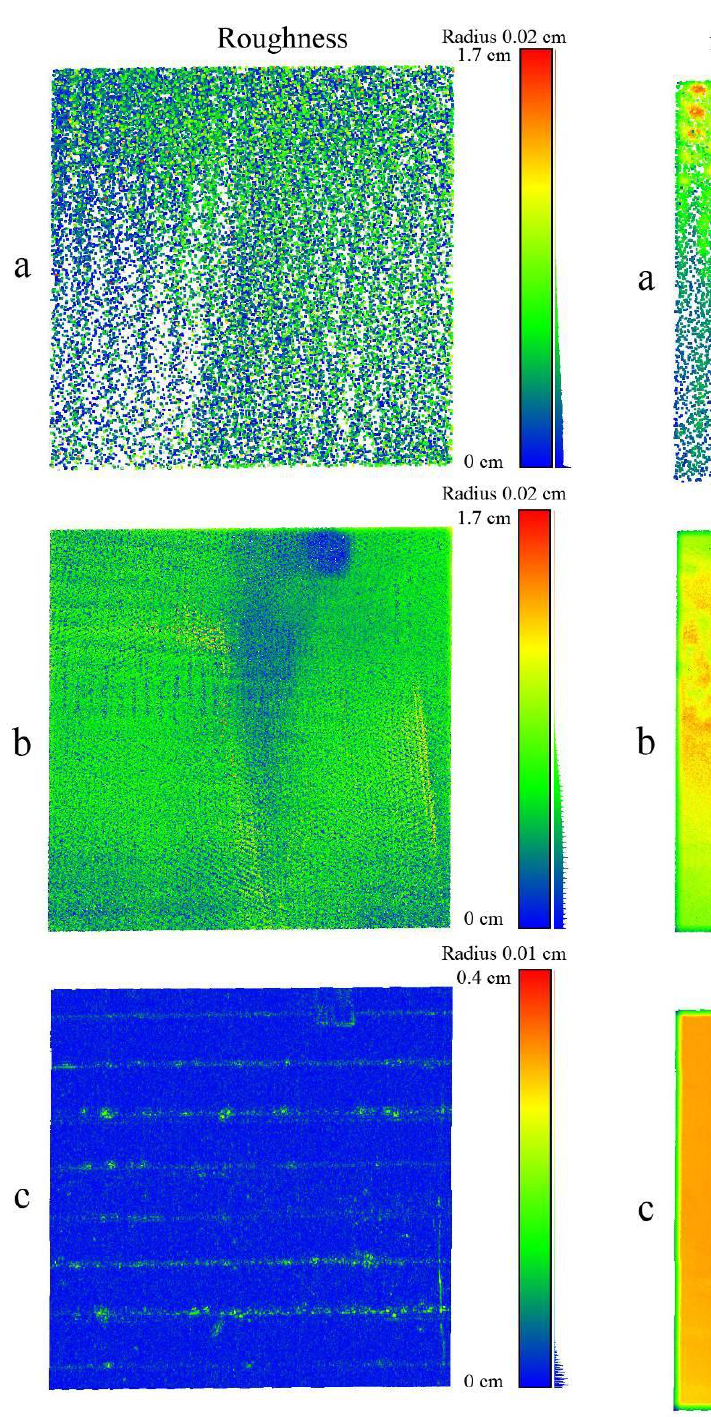
Figure 10 . Density (and frequency histogram on the right side Figure 9 . Roughness (and frequency histogram on the right side of the legend) expressed as number of neighbours in a sphere of of the legend) in a sphere of radius 2 cm of the (a) lowest radius 2 cm in an area of 1 m 2 of: (a) the lowest resolution iPad resolution iPad point cloud and (b) single higher resolution iPad point cloud, (b) single higher resolution iPad point cloud, (c) point cloud, (c) in a sphere radius of 1 cm of a single TLS point single TLS point cloud in an area of 1 m 2 .